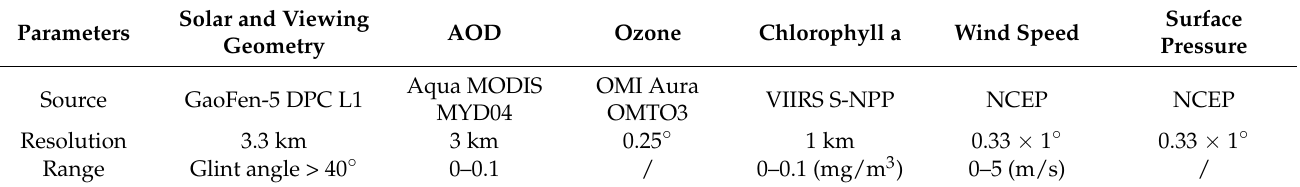
Figure 4. Location of global radiometric calibration ocean sites for Rayleigh scattering calibration and the desert sites for cross-calibration with MODIS/Aqua. Table 2. The auxiliary data source and the sample selecting criteria for Rayleigh scattering